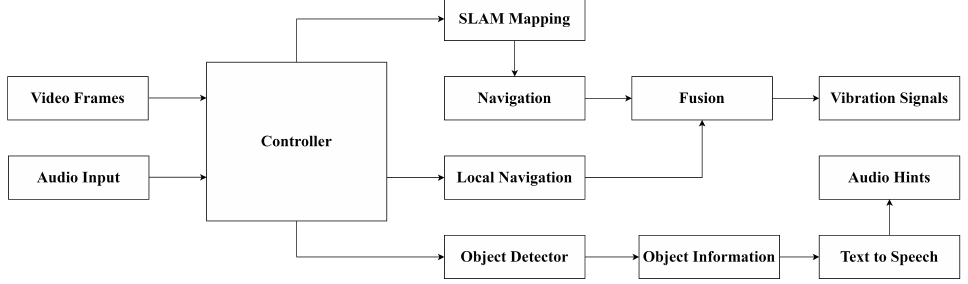
Figure 1. Algorithm flow of the proposed multi-sensory guidance